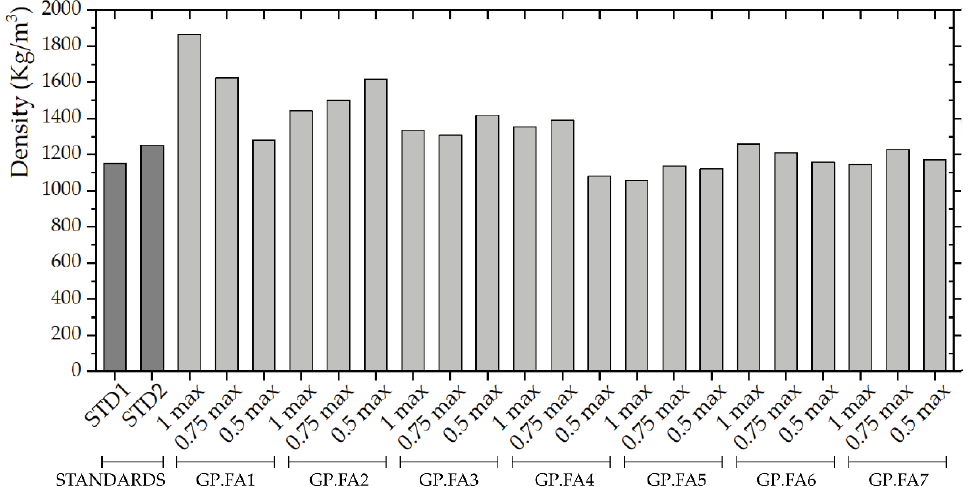
Figure 2. The densities of geopolymers strictly depend on the type of fly ash added: Loucovice at 615 °C (1), and 835 °C (2), Cesky Krumlov (3), Pisek (4), Otin (5), Mydlovy (6), and Trchov Svin (7). STD1 and STD2 are the standards: geopolymer without fly ash, and concrete Baumit 25. Table 6. Physical parameters for the optimization of fly ash-based geopolymer